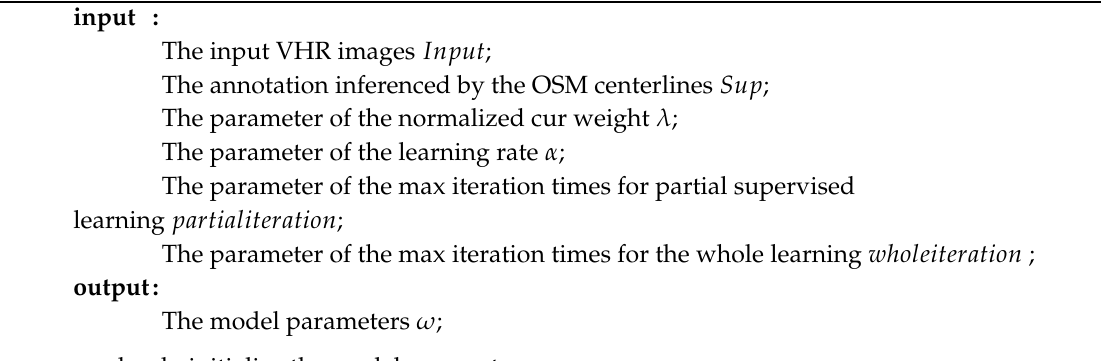
Algorithm 1: Training the MD-ResUNet